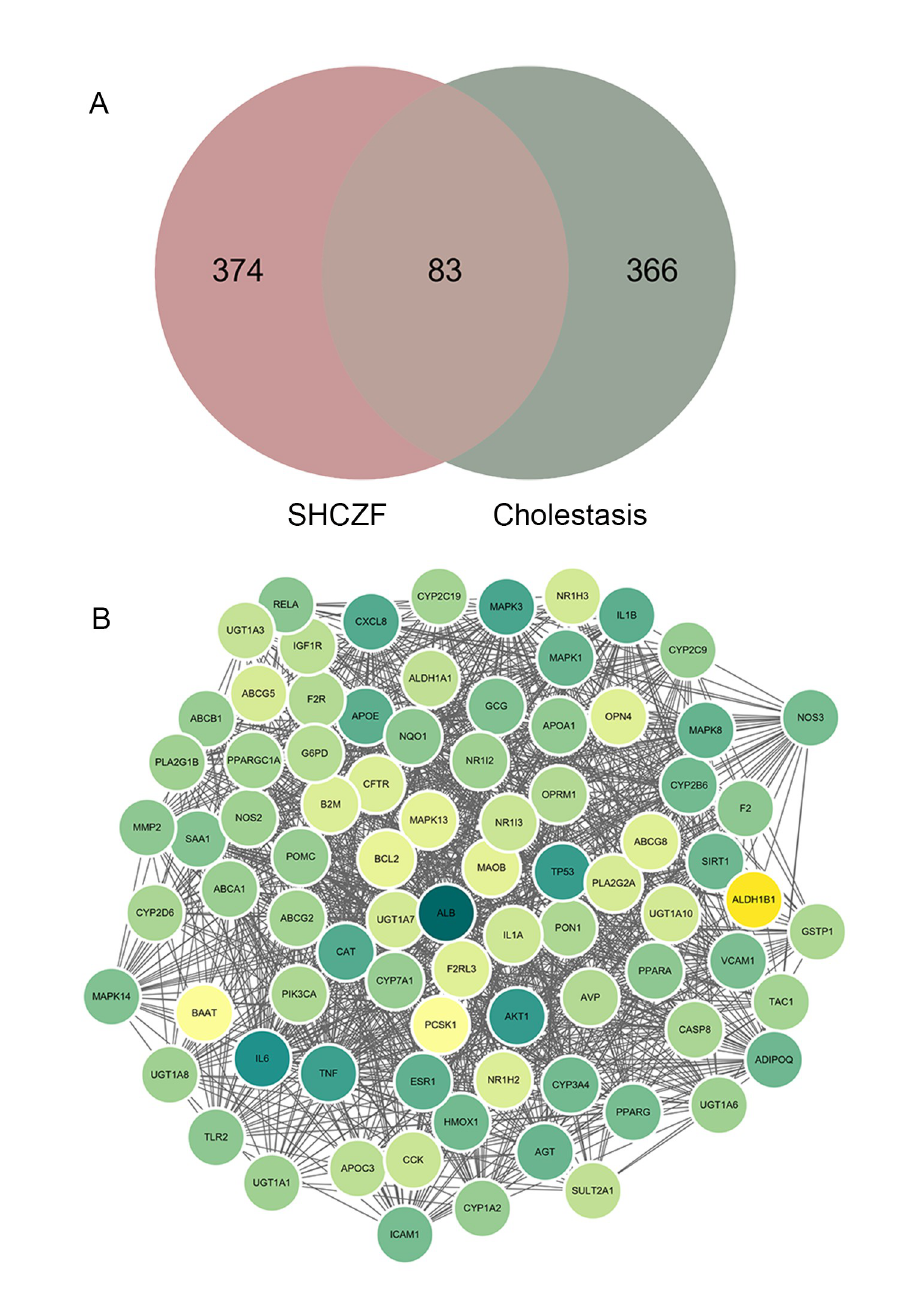
Fig 1. The 83 potential targets for San-Huang-Chai-Zhu formula (SHCZF) in cholestasis treatment. (A) Intersection of SHCZF and cholestasis targets was visualized by Venn diagram. (B) Protein-protein interaction (PPI) network of 83 common targets. Each node represents a common target for SHCZF and cholestasis, and each edge represents the association between two targets. The darker green means the higher degree value, and the average degree is